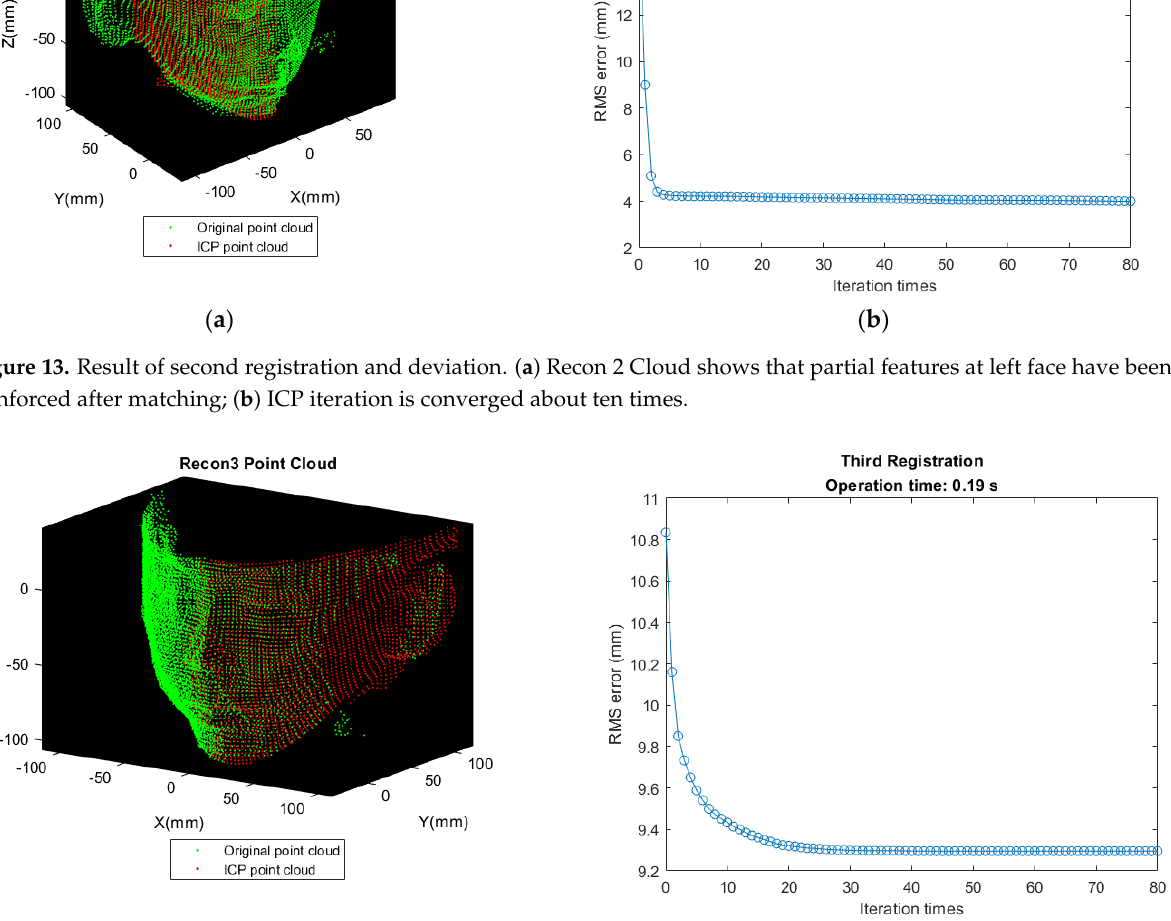
Figure 13. Result of second registration and deviation. ( a ) Recon 2 Cloud shows that partial features at left face have been reinforced after matching; ( b ) ICP iteration is converged about ten times.